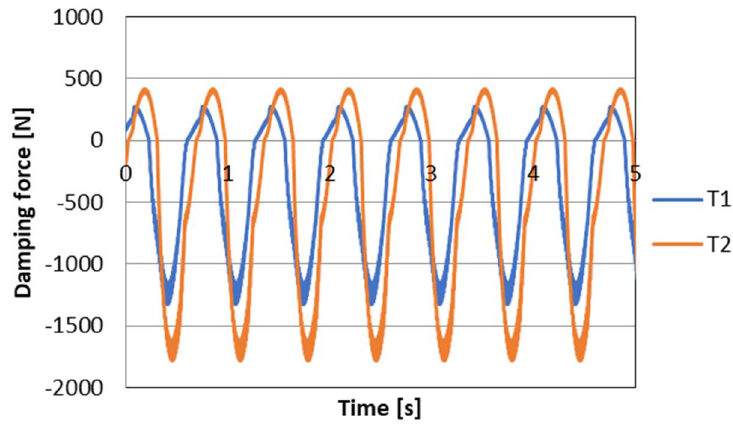
Figure 16. The course of damping forces in the suspension of the vehicle model, respectively, T1 front wheel, T2 rear wheel.